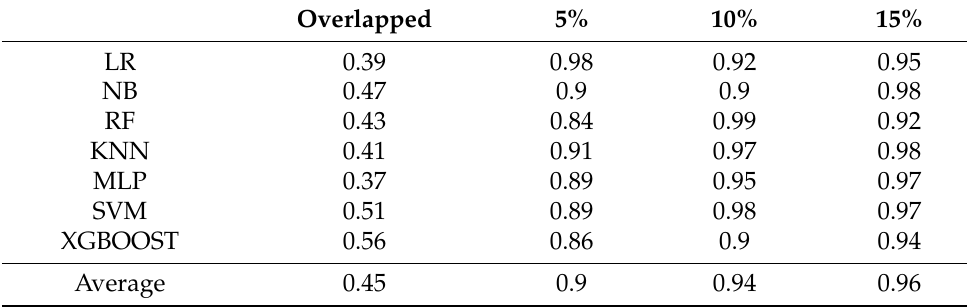
Table 6. Performance comparison of classifiers in terms of